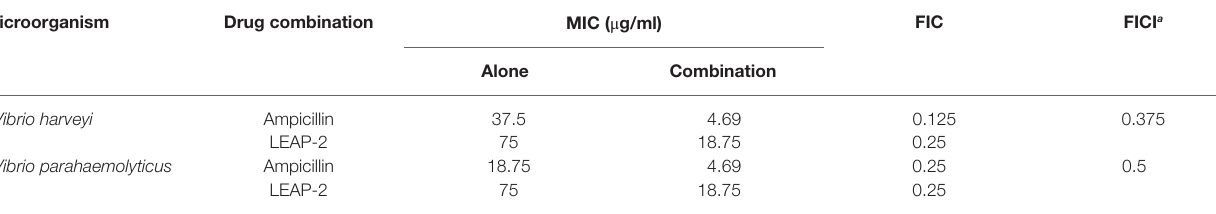
TABLE 7 | Chequerboard assay of ampicillin and topmouth culter LEAP-2 against fish pathogenic bacteria.